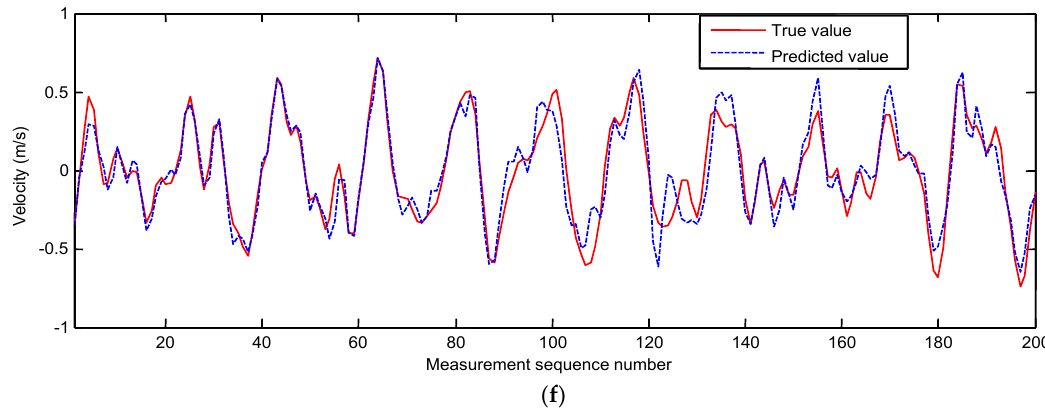
Figure 7. Test cases for the predicting effect of the nonlinear autoregressive neural network; ( a , b ) test case 1; ( c , d ) test case 2; ( e , f ) test case 3.